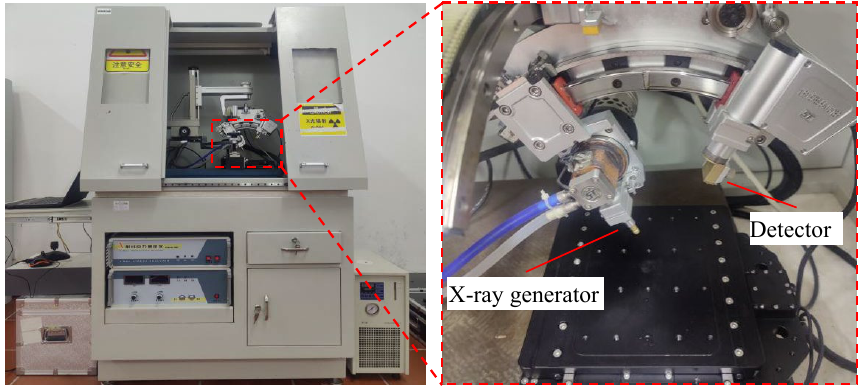
Figure 6. X-ray diffractometers.